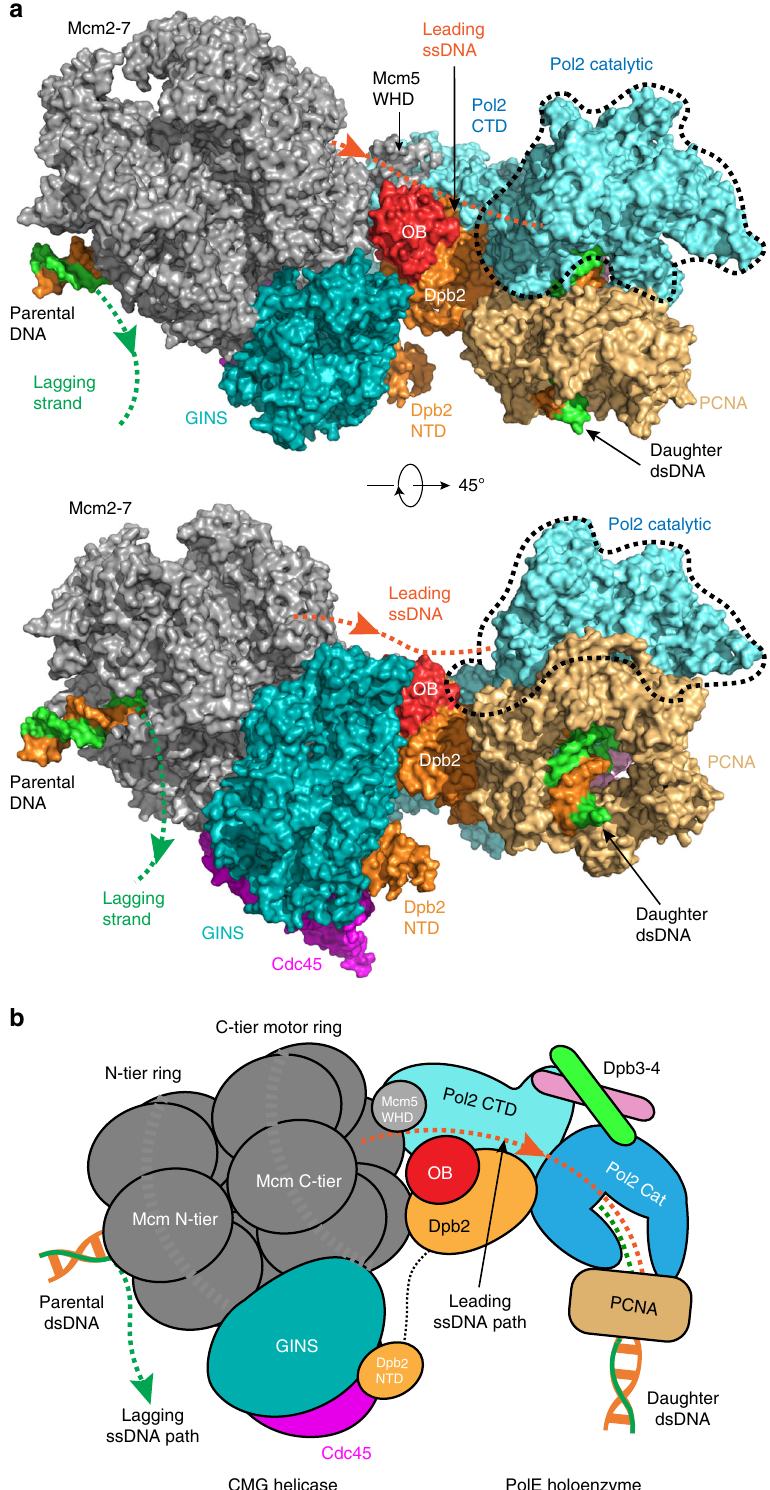
Fig. 5 Leading ssDNA path from the CMG helicase to the Pol ε . a Top and side views of the surface presentation of the atomic model of the leading strand replisome, centering around the Dpb2 OB domain. b A sketch illustrating the midway location of Dpb2 in the shortest path of the leading strand DNA from CMG to the entrance of the Pol ε catalytic